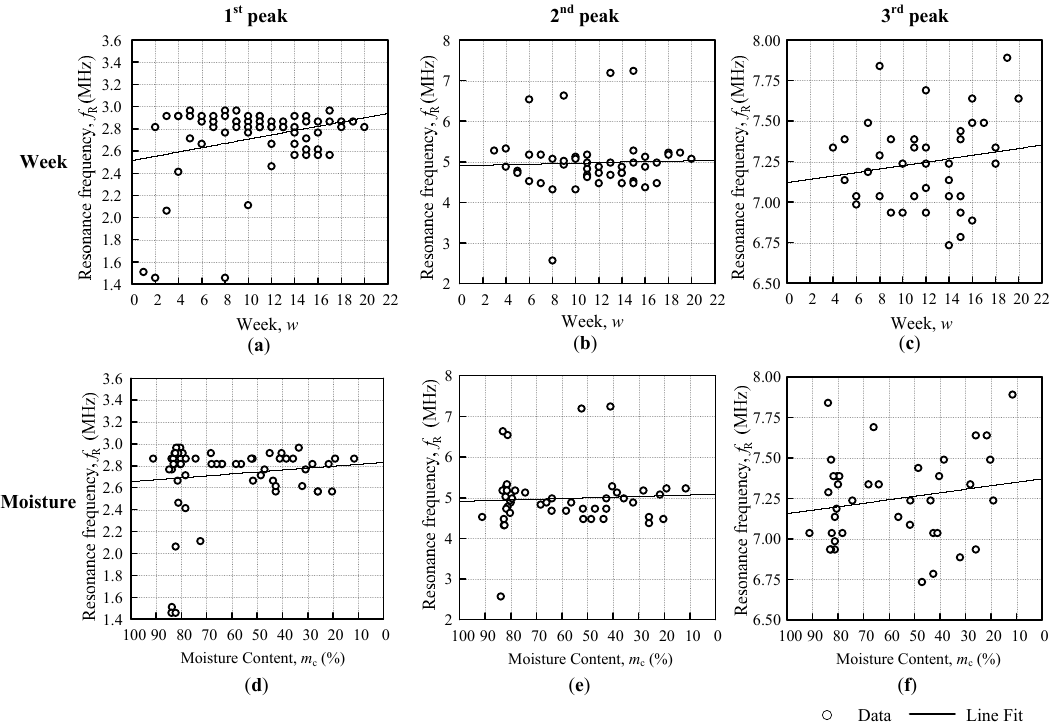
Figure 11. Triple II first, second, and third peak resonance frequency against the weeks ( a – c ) and moisture ( d – f ).